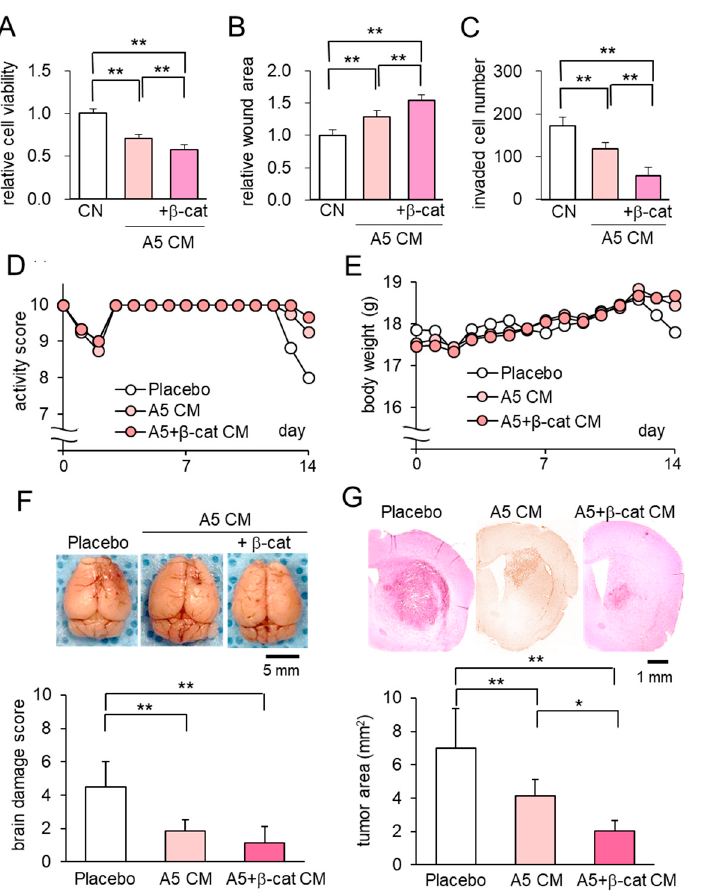
Figure 5. Anti-tumor effect of osteocyte-derived CM with β -catenin overexpression on brain tu- mors. Of note, β -cat = β -catenin, CN = control, and CM = conditioned medium. The double asterisks indicate p < 0.01. The error bar indicates a standard deviation. ( A – C ) Reduction in MTT-based cell viability, scratch-based migration, and Transwell invasion in EO771 cells by β -catenin overex- pressing CM. ( D , E ) Activity score and body weight for 2 weeks ( N = 8 per group). ( F ) Whole brains in the three groups (placebo, and the injections of A5 CM and β -catenin overexpressing A5 CM) with the brain damage score. ( G ) Histological analysis, showing that osteocyte-derived CM with the overexpression of β -catenin significantly suppressed tumor growth.